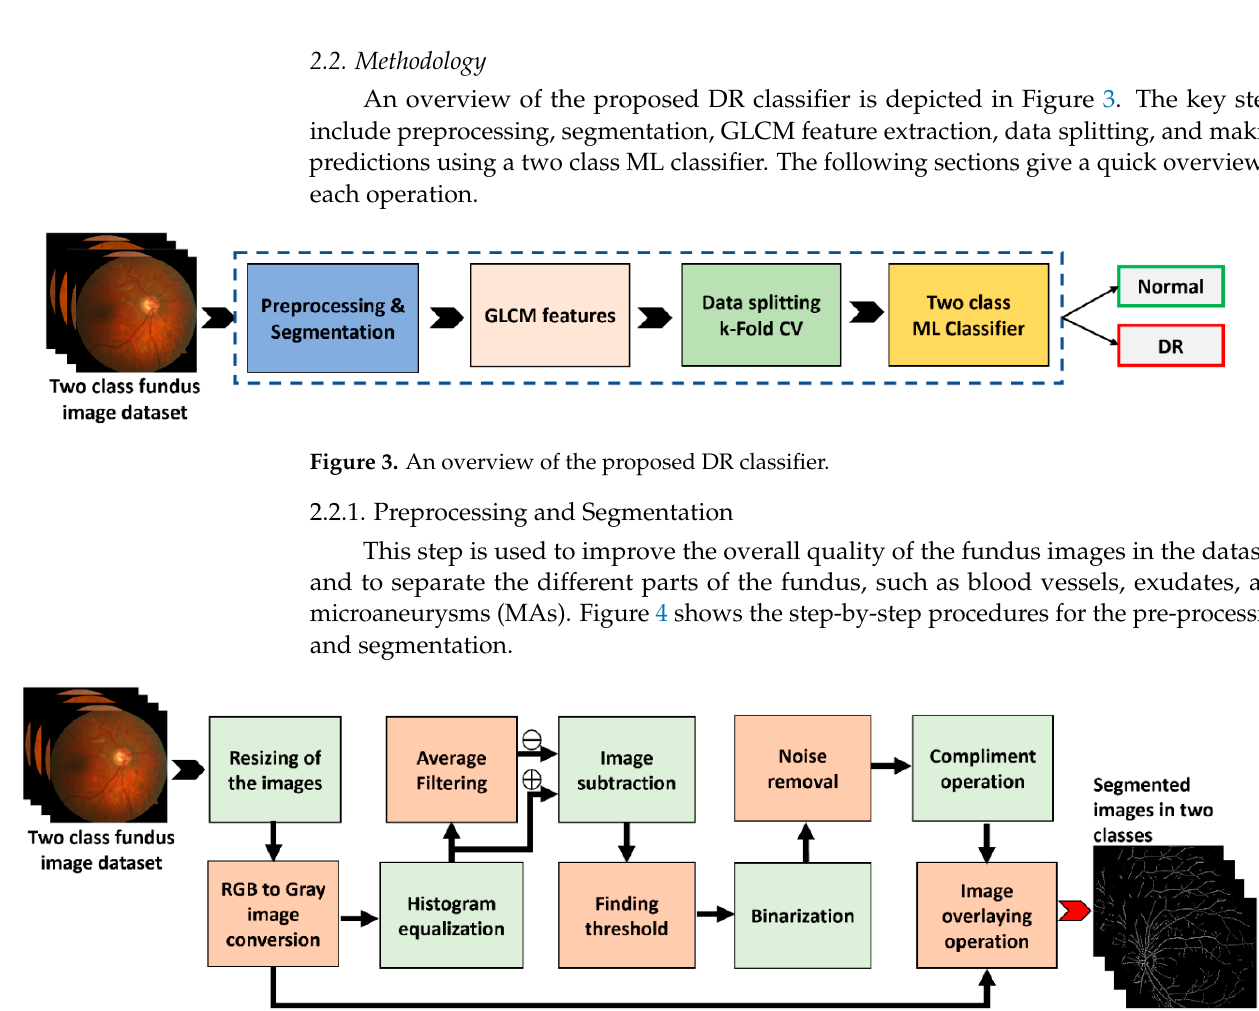
Figure 2. Sample images from both classes: ( a , b ) Healthy fundus. ( c , d ) DR fundus.